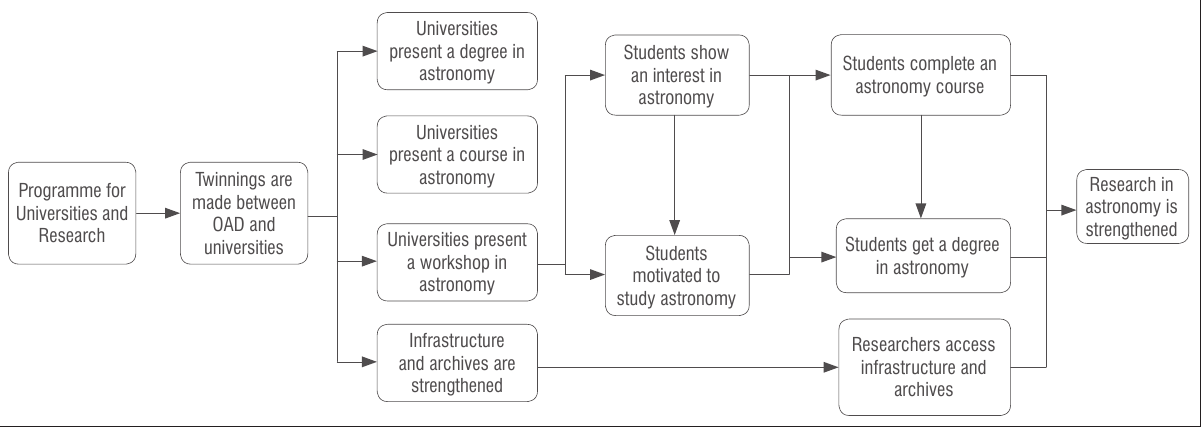
Table 1: Process and outcome indicators and measures for the Programme for Universities and Research Process/Outcome Indicators Measures Data source Amount, type, quality of Number and type of connections, signed Memorandum of Twinnings made (process) twinning Understanding, participant satisfaction, etc. Amount, type, quality of ratingsWorkshops presented (process) Number and type of workshops, participant satisfaction, etc. workshops presented Number of new courses/degrees